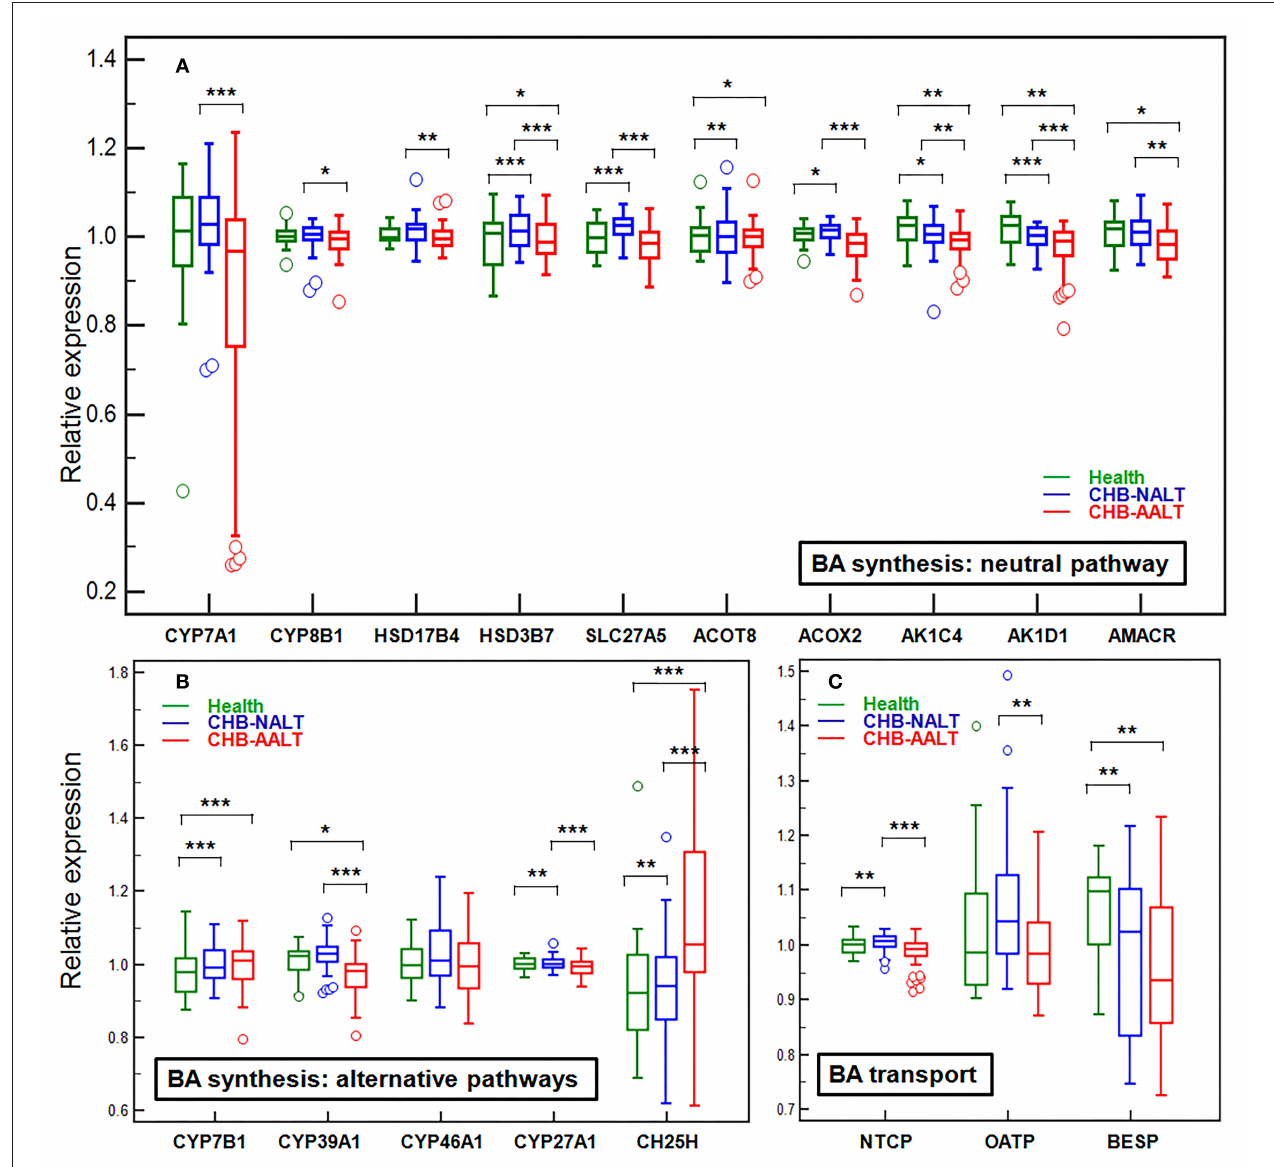
FIGURE 3 | Alteration of hepatic genes related to BA transport and synthesis in CHB patients. The expression levels across all three groups were compared for genes related to de novo synthesis by (A) main neutral pathway, (B) alternative acidic or 24/25-hydrolyase pathways and (C) BA transport. All expression levels were normalized against the medium level. Error bars represented 25–75% quartile. P values were determined by the Mann–Whitney U test, significant differences were noted by * p < 0.05, ** p < 0.01, *** p < 0.001. CHB-NALT: ALT normal patient group, CHB-AALT: ALT abnormal patient